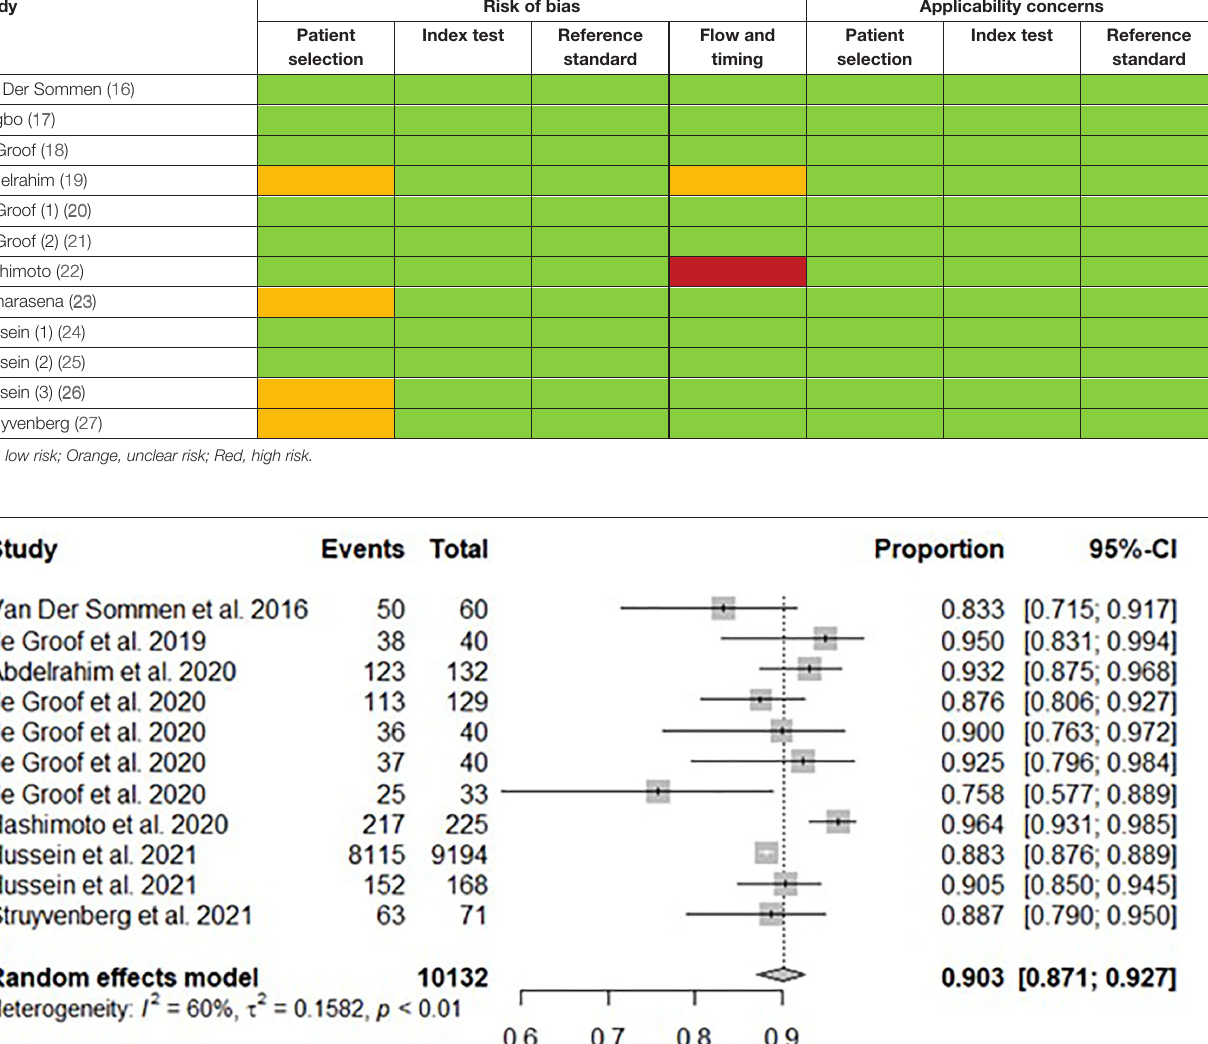
Frontiers in Medicine |